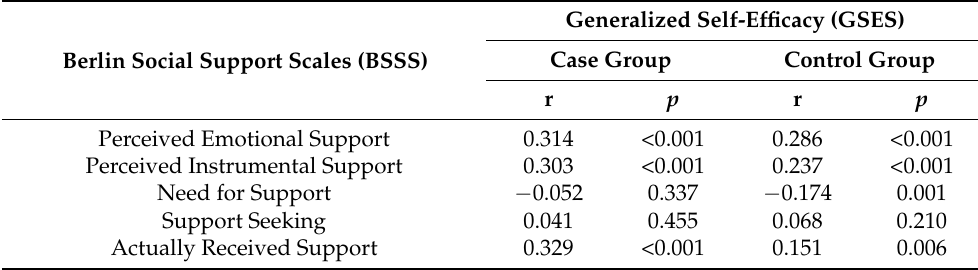
Table 7. The correlation between generalized self-efficacy and social support of women with diabetes during